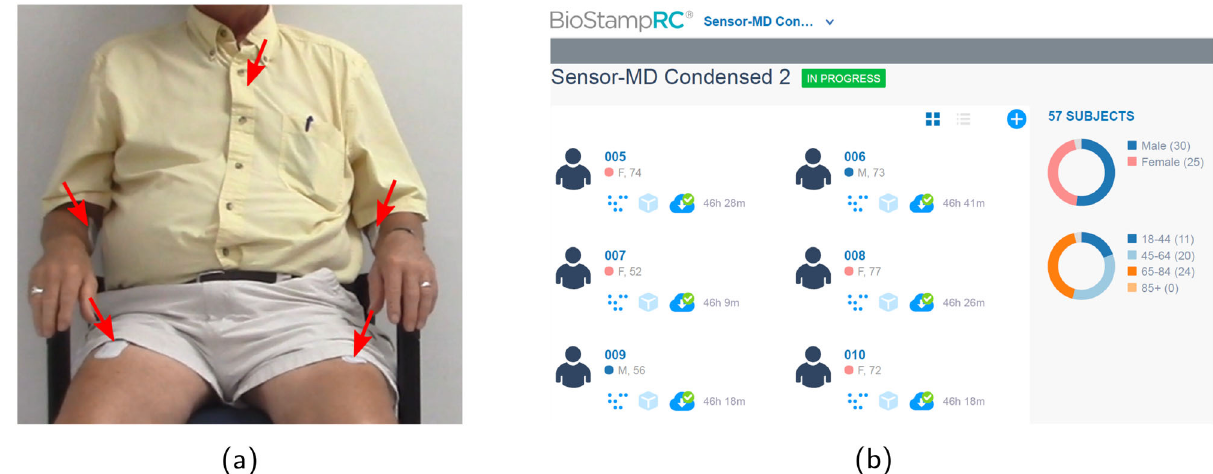
Fig. 2 Sensor placement and cloud-based web portal for accessing data. a A study participant wearing the sensors at fi ve different locations on the trunk and each limb, and b web-portal for accessing the recorded sensor data over the duration of sensor wear. As part of the written consent for participation in the study, the participant shown in ( a ) provided permission for their image to be